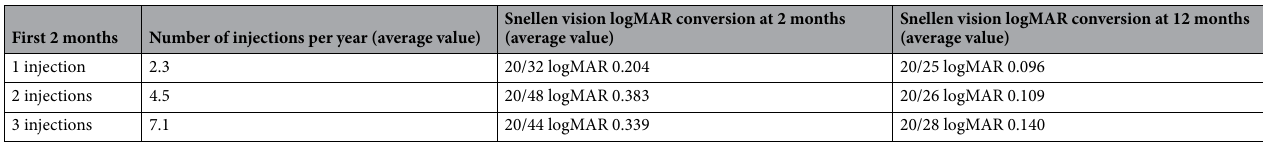
Table 2. The number of injections per year and logMAR values after 2 months and 12 months in relation to the number of injections up to 2 months. logMAR logarithm of the minimum angle of